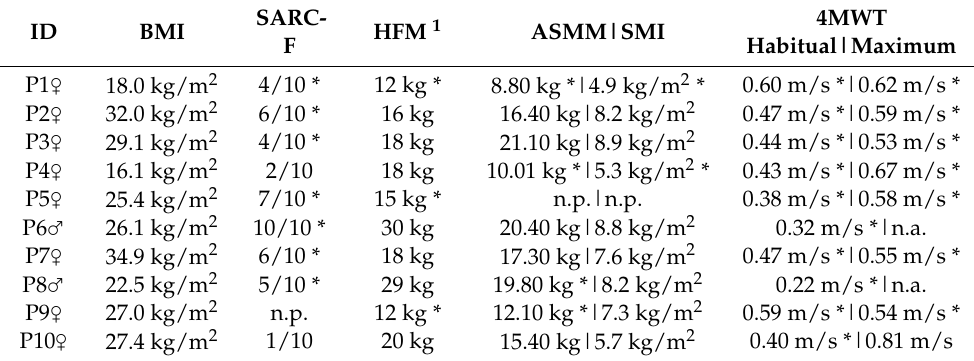
Table 4. Primary outcomes.